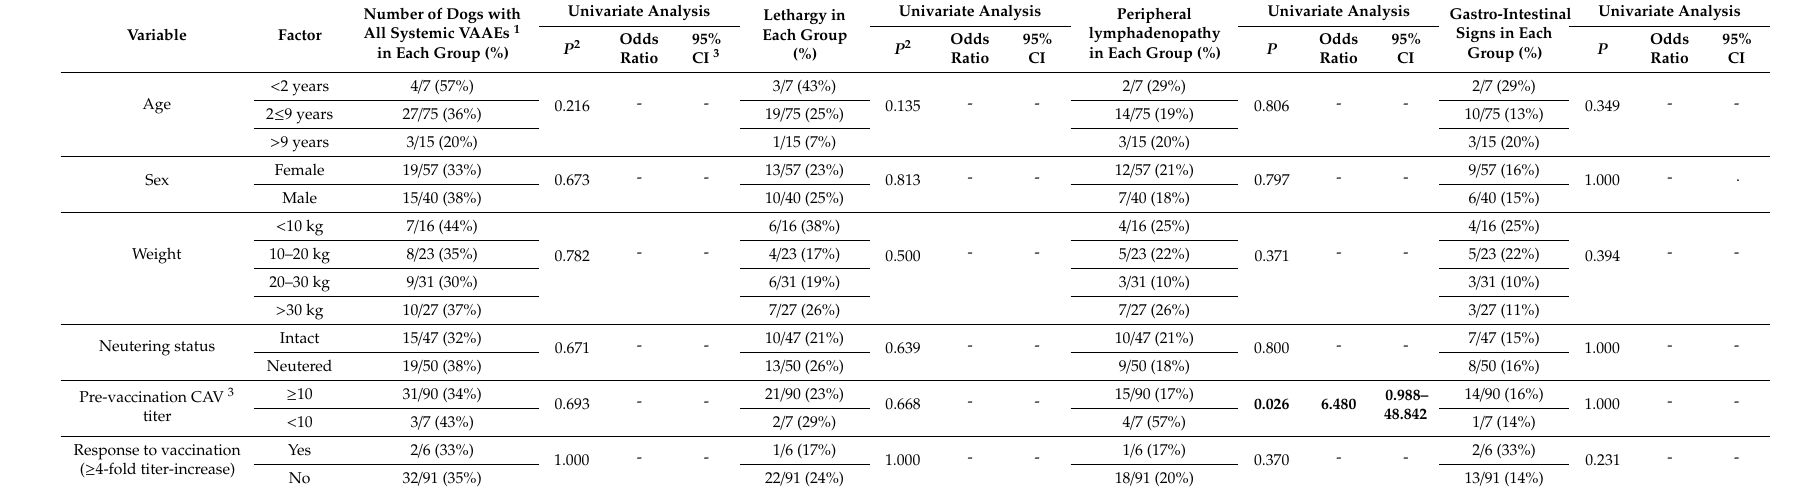
Table 3. Factors associated with systemic vaccine-associated adverse events occurring in 34 dogs after modified live canine adenovirus-2 vaccination in univariate